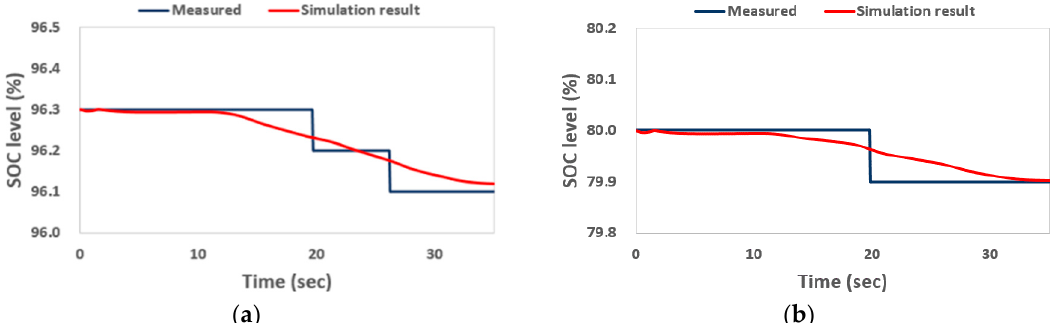
Figure 9. Comparison of averaged SOC level of ( a ) left battery and ( b ) right battery for measured and simulated results at a ground speed of 10 km/h under off-road conditions.